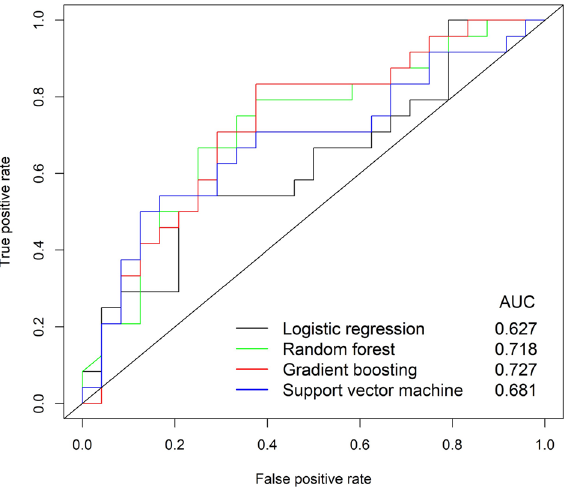
Figure 3. Receiver operating characteristic (ROC) curves for machine learning models. Area under the curve (AUC) are shown for each model. The color of lines in the ROC curve represents each algorithm; logistic regression (black); random forest (green); gradient boosting (red); support vector machine (blue). GBM, gradient boosting machine; SVM, support vector machine.